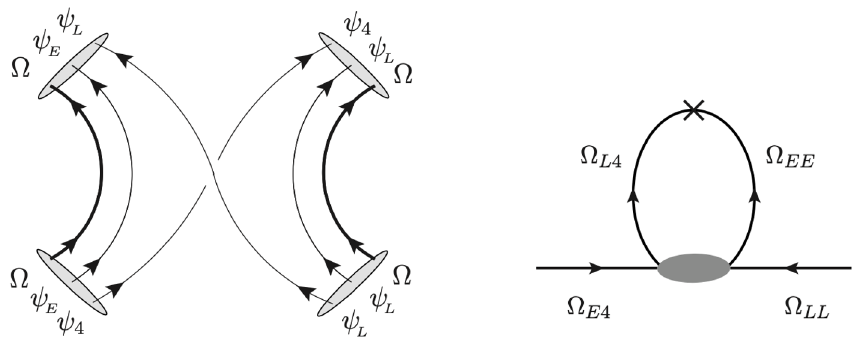
(cid:0) (cid:1) Ω L 4 Ω LE generated by SU(15) p dynamics at